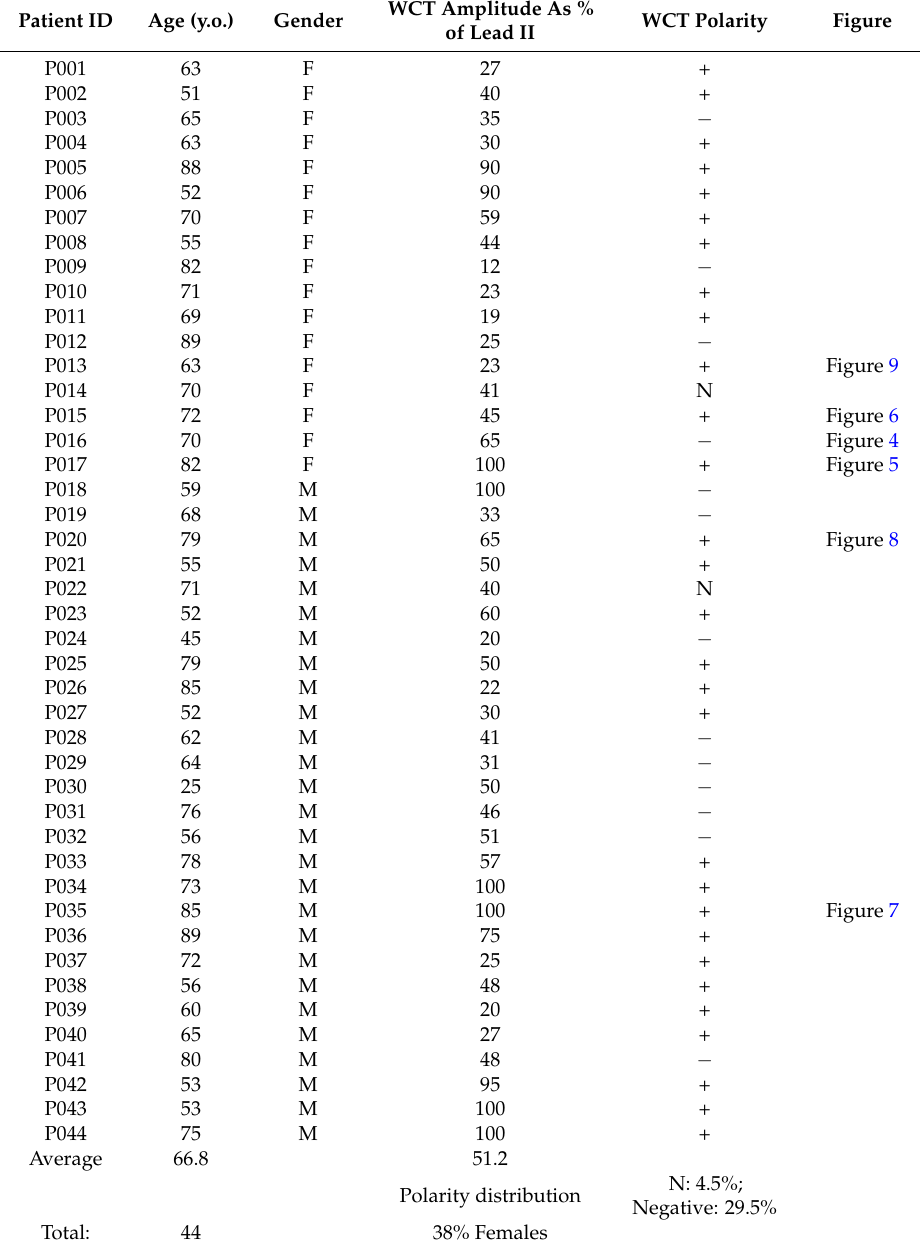
Table 2. Summary of measurement results. WCT relative amplitudes are approximated to the nearest integer and capped to 100% for the measurements larger than 99% (see